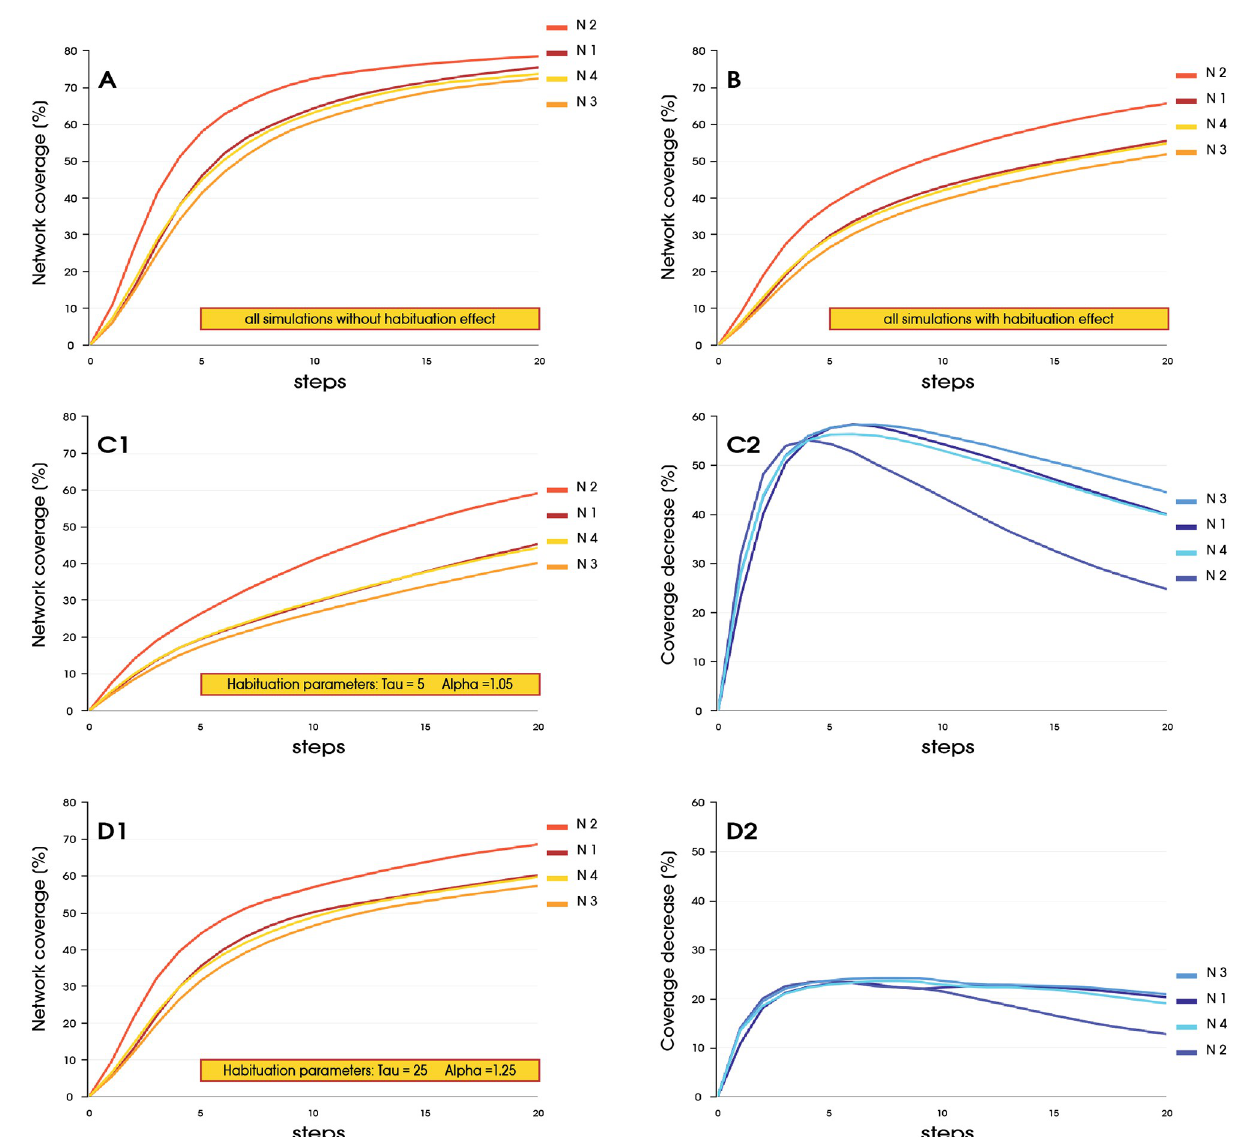
Fig 5. ( A ) Coverage for each network for all spreading processes without habituation. ( B ) Coverage for each network for all spreading processes with habituation. ( C1 ) Coverage for each network for spreading processes with the “worst” set of habituation parameters. ( C2 ) Decrease in coverage for each network in relation to a process without habituation with the “worst” habituation parameters. ( D1 ) Coverage for each network for spreading processes with the “best” set of habituation parameters.( D2 ) Decrease in coverage for each network in relation to a process without habituation with the “best” habituation